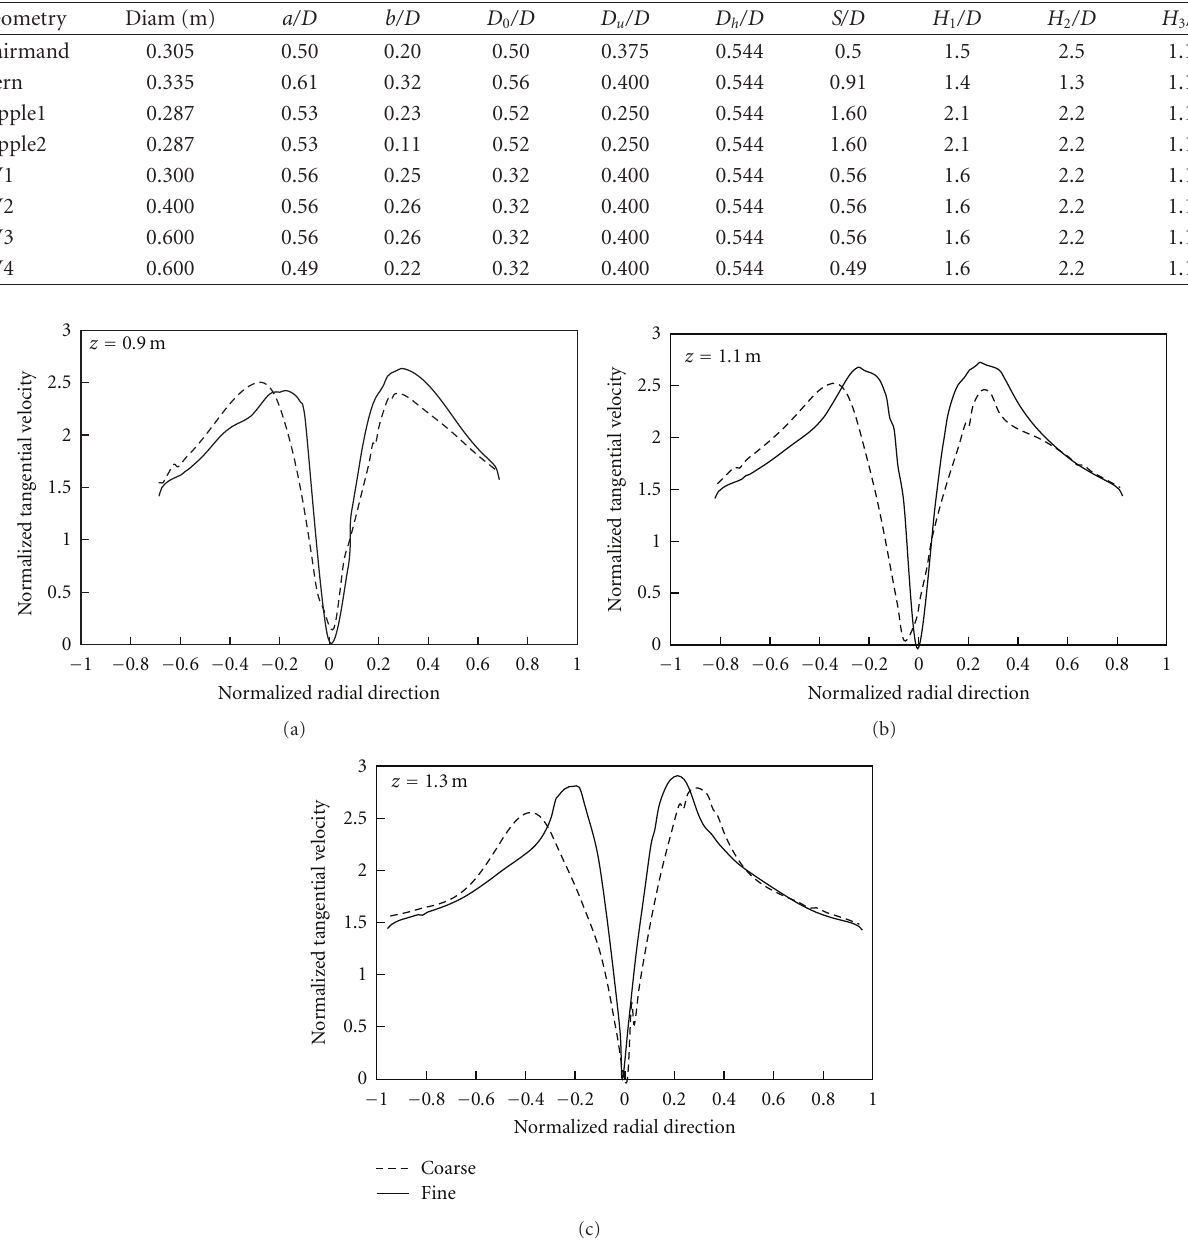
Figure 3: Radial profiles of the tangential velocity component at di ff erent positions in the axial direction z of the geometry PV2 (coarse mesh = 112376 cells, fine mesh = 230224